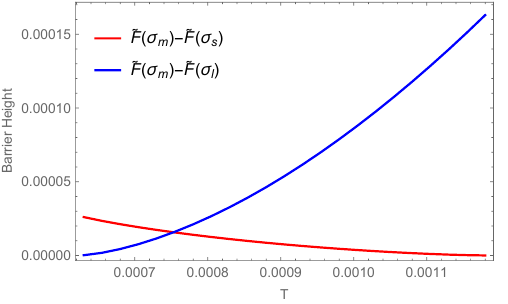
Figure 9 . Barrier height (red line) between the stable wormhole phase (the green dot on the free energy landscape in figure 5) and the unstable wormhole phase (black dot on the free energy landscape) and barrier height (blue line) between the two black hole phase (the red dot on the free energy landscape in figure 5) and the unstable wormhole phase (black dot on the free energy landscape).